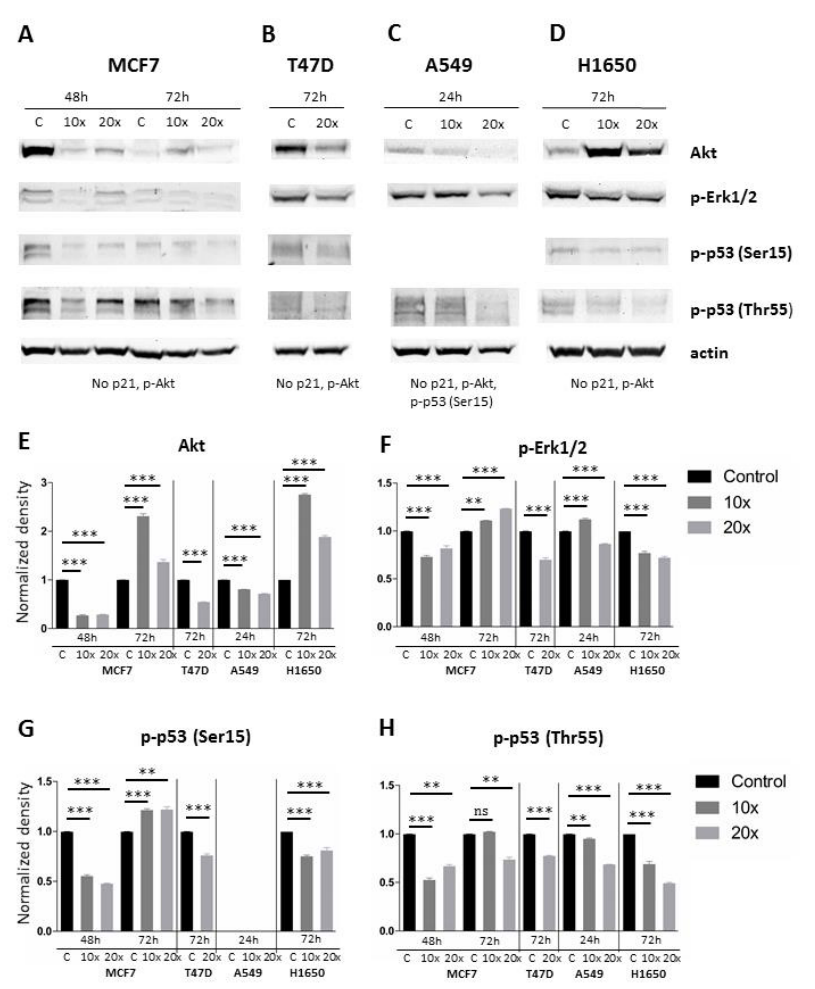
Figure 7. Changes of the level of selected signaling proteins after methyl-donor treatment in MCF7, T47D, A549, and H1650 cell lines. ( A – D ). Results of the Western-blot analysis of Akt, p-Erk1/2, p-p53(Ser15, p-p53(Thr55) and actin as a loading control. ( E ). Statistical analysis of Akt protein expression in all cell lines ( n > 3). ( F ). Statistical analysis of p-Erk1/2 protein expression in all cell lines ( n > 3). ( G ). Statistical analysis of p-p53(Ser15) protein expression in all cell lines ( n > 3). ( H ). Statistical analysis of p-p53(Thr55) protein expression in all cell lines ( n > 3).Akt and p- Erk1/2 decreased significantly in most cases. Pan Akt, however, increased significantly at 72h in MCF7, and similarly in H1650 cells ( E ), as well as the p-Erk1/2 at 72h in MCF7 and at 10x dilution in A549 ( F ). Phosphorylation of p53 (Thr55) decreased significantly in all cases ( H ), while activated p53 (Ser15) increased significantly at 72h in MCF7 ( G ). Each bar represents the average normal- ized density from at least 3 repeats ± SD. Statistical significance is plotted as **: p < 0.002, and ***: p < 0.001. C: control. ×10 and ×20: concentrations of methyl-donors. 3. Discussion Several earlier studies have suggested that dietary methyl-donors could contribute to cancer prevention as high intake of methyl-donors and related vitamins could reduce the risk of breast and lung cancers [8–11]. Accumulating data have shown recently how dietary vitamins and herbal extracts can influence signaling pathways both in normal and tumor cells [32–35]. In this work, we further studied the effects of methyl-donors (using a mixture of L-methionine, choline chloride, folic acid, and vitamin B12) on breast (MCF7 and T47D) and lung (A549 and H1650) cancer cell lines. We could confirm our starting